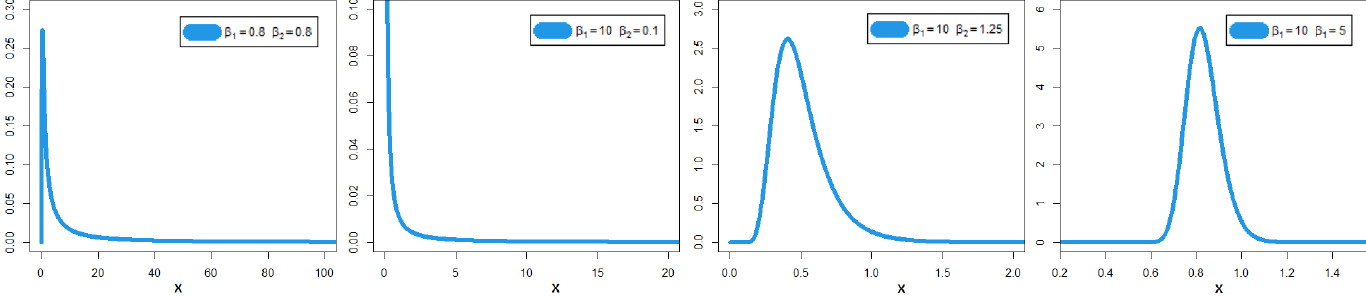
Figure 1: Plots of the PDF for selected parameter values.